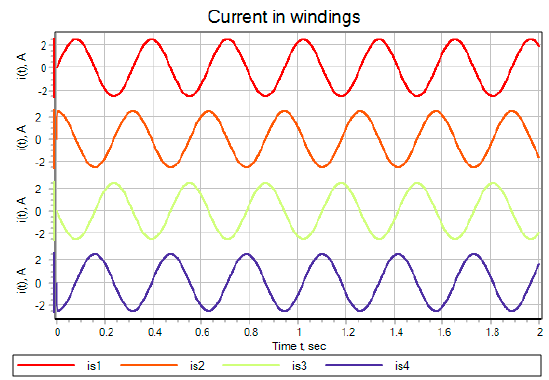
Figure 19. Current flowing in the generator windings.